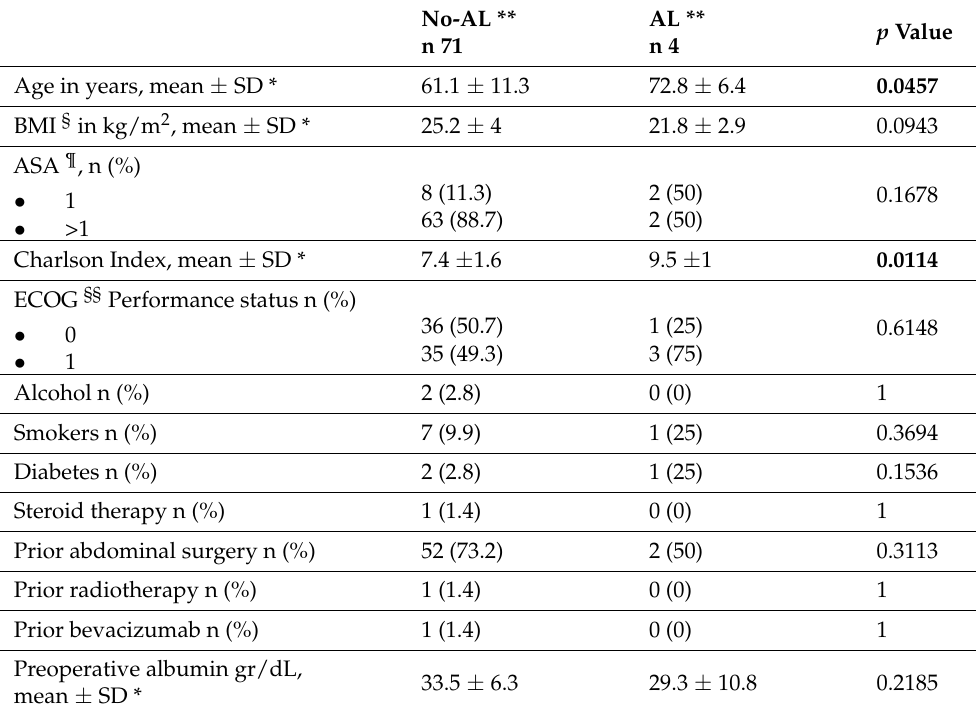
Table 5. General characteristics analysis between no-AL and AL subgroups.